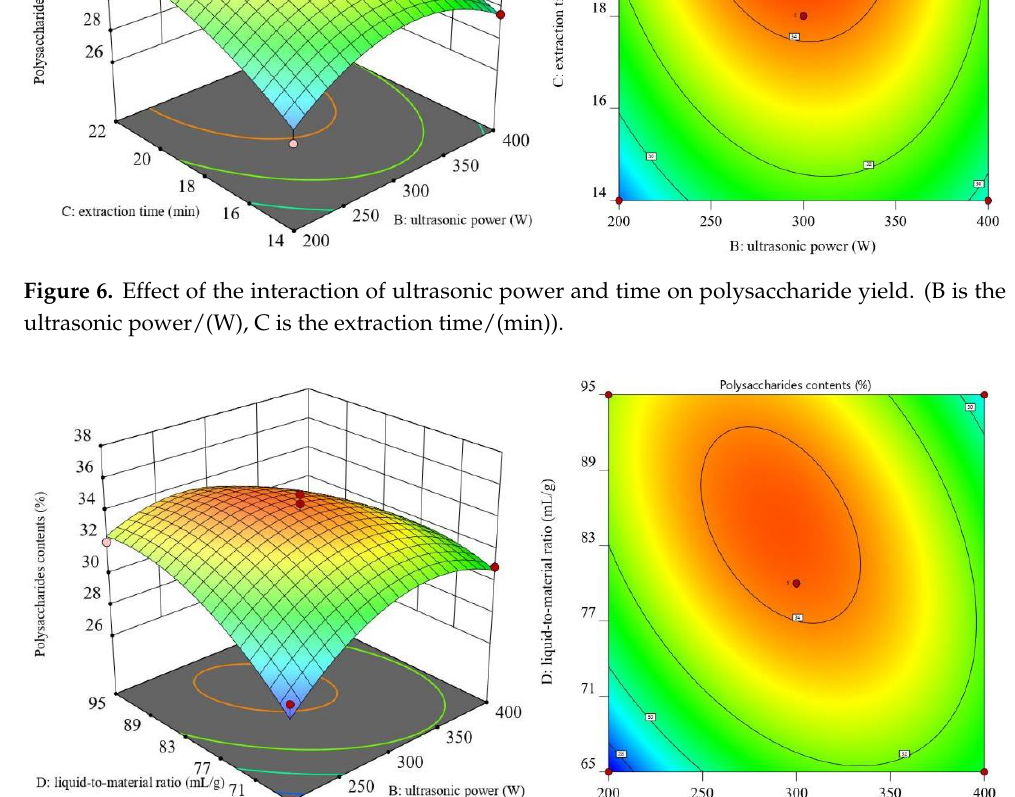
Figure 7. Effect of the interaction of ultrasonic power and liquid-to-material ratio on polysaccharide yield. (B is the ultrasonic power/(W), D is the liquid-to-material ratio/(g/mL)).